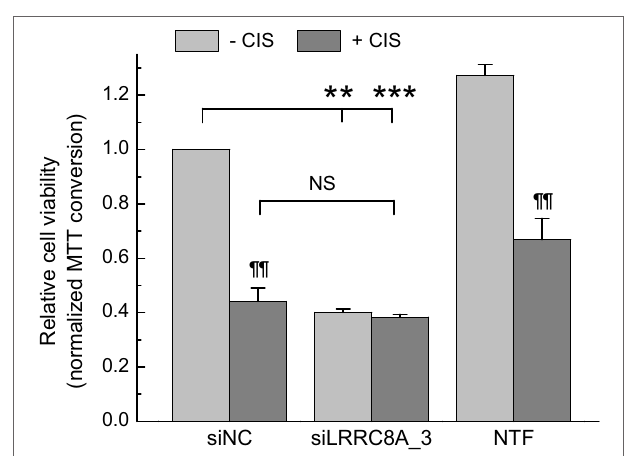
FigUre 5 | Effects of cisplatin and leucine-rich repeat-containing 8A (LRRC8A) siRNA on viability of glioblastoma (GBM) cells. GBM cells were transfected with siLRRC8A_3 or negative control siRNA (siNC). 48 h post-transfection cells were additionally treated with 30 µM cisplatin or matching concentration of the vehicle (Dulbecco’s phosphate-buffered saline). Cell viability was determined 48 h after addition of cisplatin (96 h post-transfection with siRNA) using an 3-(4,5-dimethylthiazol-2-yl)-2,5- diphenyl tetrazolium bromide (MTT) assay. Non-transfected cells (NTF) were used as an additional internal control. The data are the mean values ± SE of three independent experiments performed in triplicates ( n = 3). ** p < 0.01, *** p < 0.001 vs. cells transfected with siNC. ¶¶ p < 0.01, within the group effect of cisplatin vs. siRNA or mock treatment alone. NS, not significant, cisplatin effects in cells treated with siNC vs. cells treated with siLRRC8A_3.